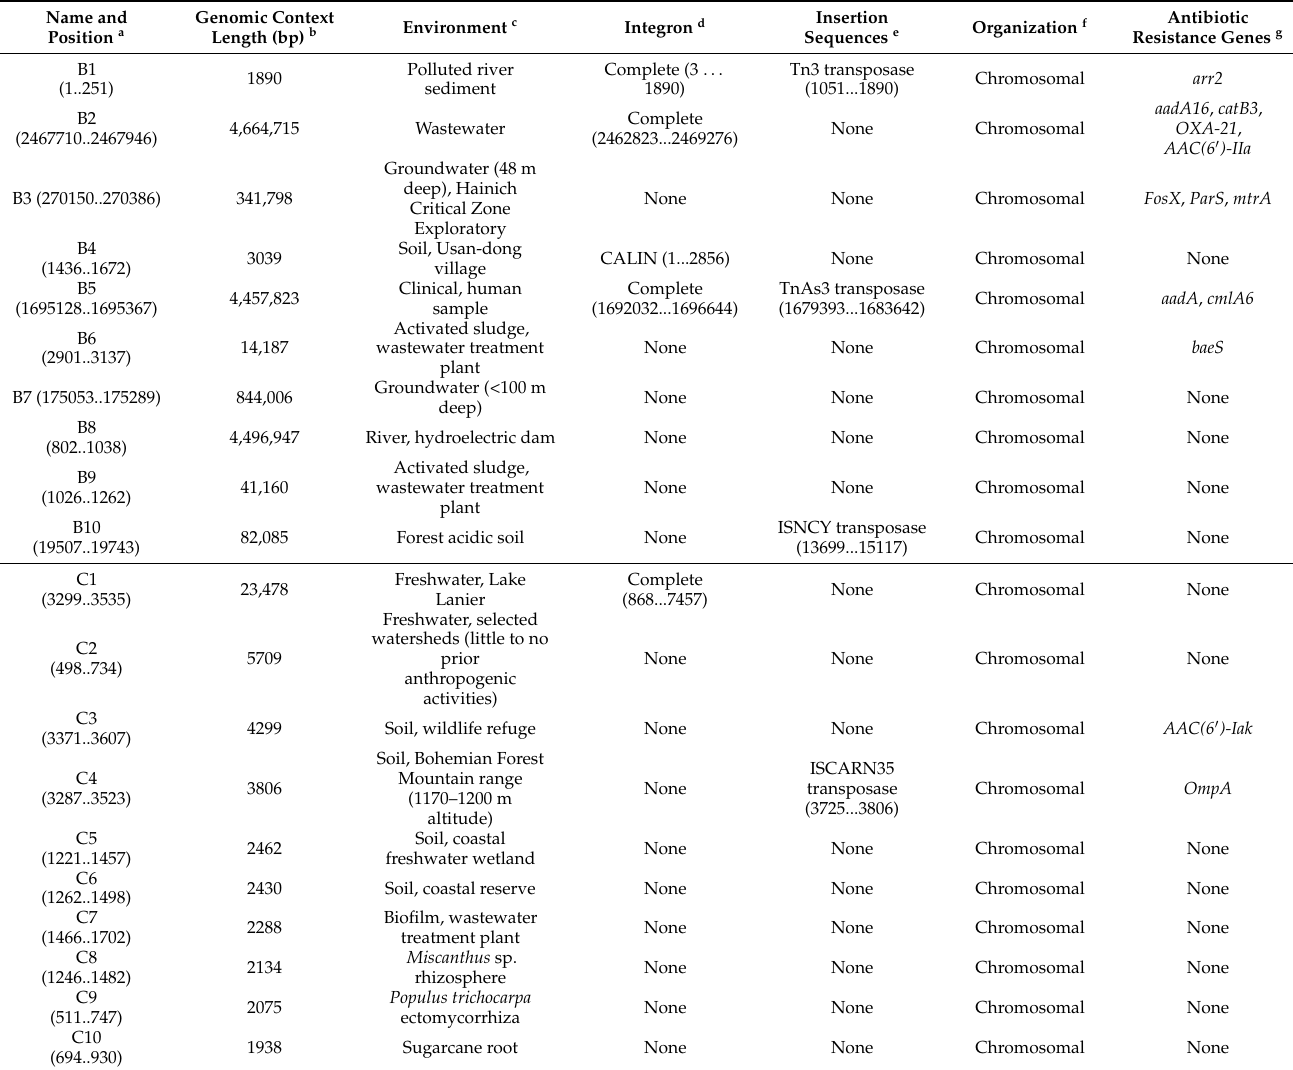
Table 2. Genomic context analyses of putative dfrB from BLASTP and JGI/IMG